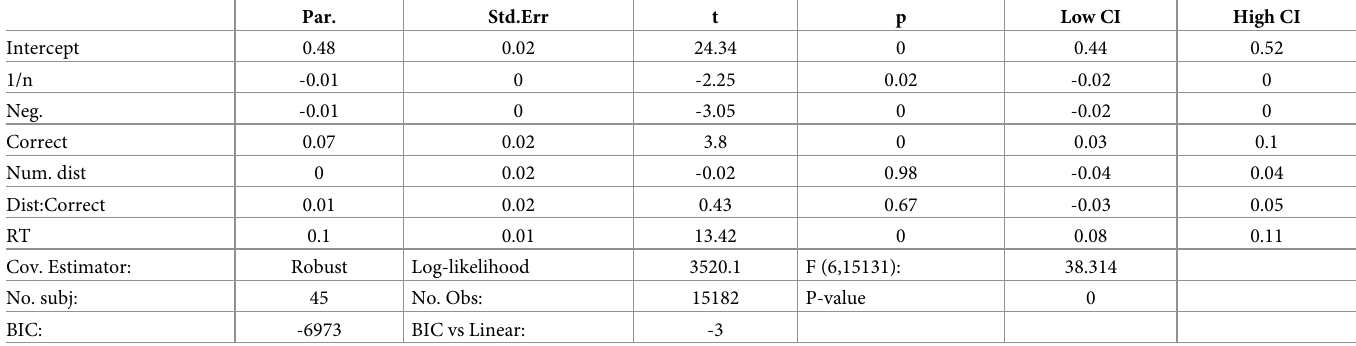
Table 3.3. Max. Press. Exp 3. Fixed Effects Estimation.